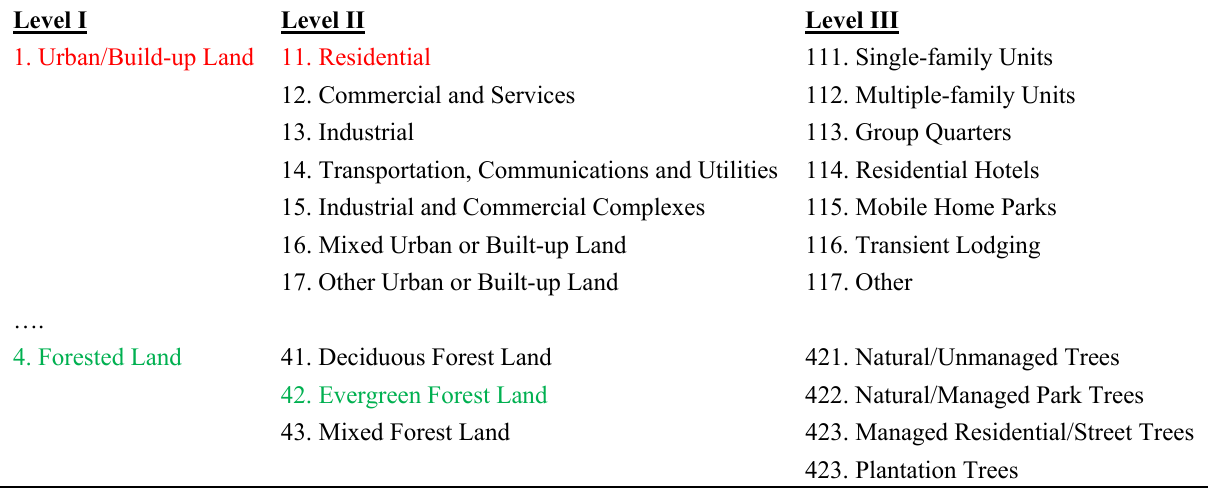
Table 1. Anderson hierarchical classification system showing examples of Levels I–III for Urban and Forest Lands [10]; only the classes in red and green have been expanded upon in the